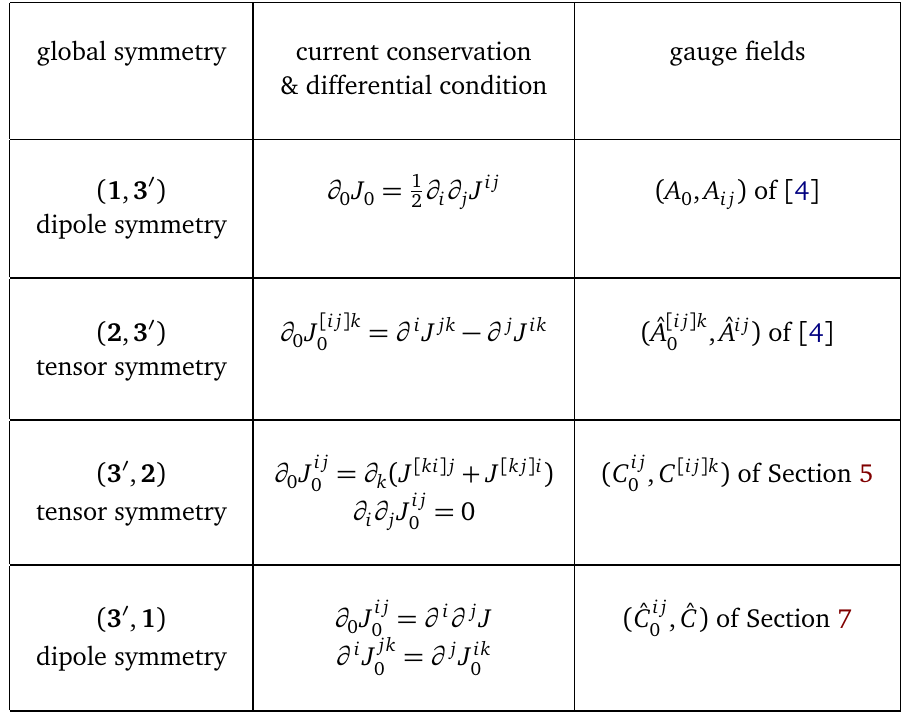
Table 4: The four exotic U ( 1 ) global symmetries of [ 4 ] and their associated gauge fields. Each global symmetry is labeled by the S temporal and spatial components of its conserved current. The temporal components of the currents for the third and the fourth global symmetries obey a differential condition in addition to the current conservation